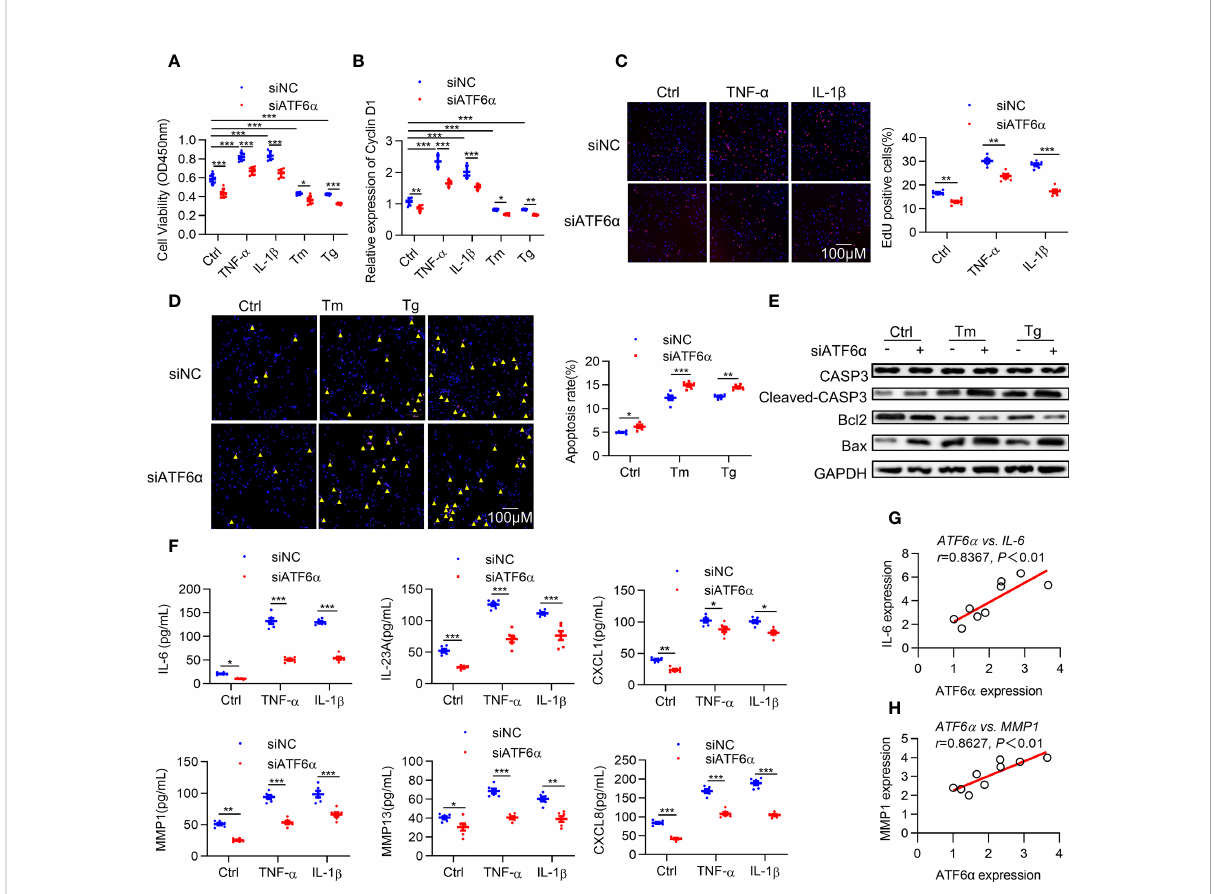
FIGURE 2 ATF6 a is required for the aggressive phenotype of RA FLSs. RA FLSs were transfected with ATF6 a -siRNA (siATF6 a ) or the control (siNC) for 72 h and subsequent vehicle (Ctrl), TNF- a (10 ng/mL), IL-1 b (10 ng/mL), Tm (2 m g/mL), or Tg (300 nM) for another 72 h (A) , 6 h (B) or 24h (C – F) . (A) , Cell viability was detected via CCK-8 assay. (B) Total cellular RNA was extracted, and cyclin D1 mRNA expression was analyzed by qPCR. (C) Cell proliferation was determined by EdU staining, and EdU incorporation was calculated as EdU-positive cells/total cells and quanti fi ed by ImageJ. (D) Apoptosis was evaluated by TUNEL assay and expressed as percentage of TUNEL-positive cells. (E) Total protein was extracted for Western blot detection of CASP3, Cleaved-CAPS3, Bcl2, and Bax. (F) Cytokine levels in cell culture supernatants were measured by ELISA. (G, H) , Correlations of cytokines (IL-6 and MMP1) and ATF6 a expression. Data were expressed as mean ± SD( n =6), n represent biologically independent samples (A, B, F) or fi elds of view (C, D) . The data were analyzed using two-way ANOVA (A – D, F) and Spearman